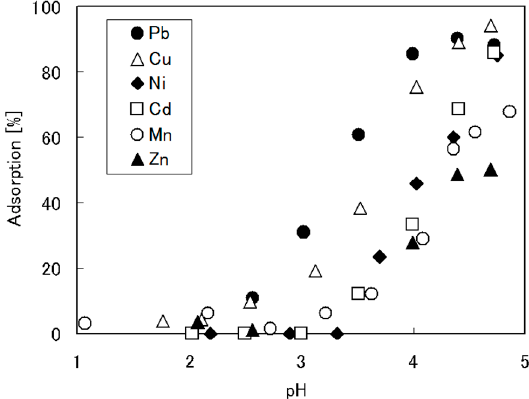
Figure 5. Adsorption of some divalent metal ions by crosslinked lignosulfonate gel at different equilibrium pH values. Initial metal ion concentration = 15 mg/L, dry weight of gel = 10 mg, test solution volume = 7.5 mL [8]. (With permission for reuse from The Society of Chemical Engineers, Japan). Adsorption isotherms indicated that La(III), Cu(II), and Pb(II) were adsorbed according to the Langmuir’s adsorption isotherm model. The maximum amount of La(III), Cu(II), and Pb(II) that were adsorbed were 0.47, 0.86 and 0.76 mol/kg, respectively. The maximum amount of Pb(II) that was adsorbed by the lignosulfonate gel was lower than the maximum amount adsorbed by the lignocatechol gel. However, Pb(II) and Zn(II) were separated well using a column packed with the lignosulfonate gel.